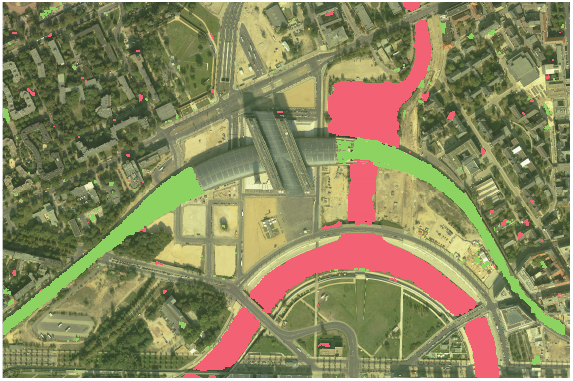
Figure 12. River (red) and railway (green) classified using the BoW method. The classification performance is consistent as the evaluation in Figure 11 shows.